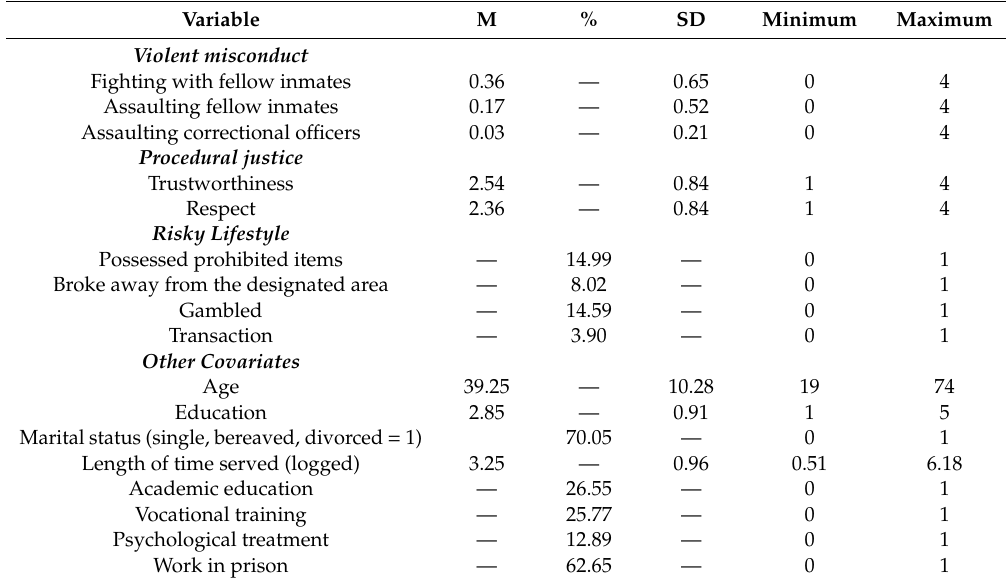
Table 1. Study sample descriptive statistics (N =